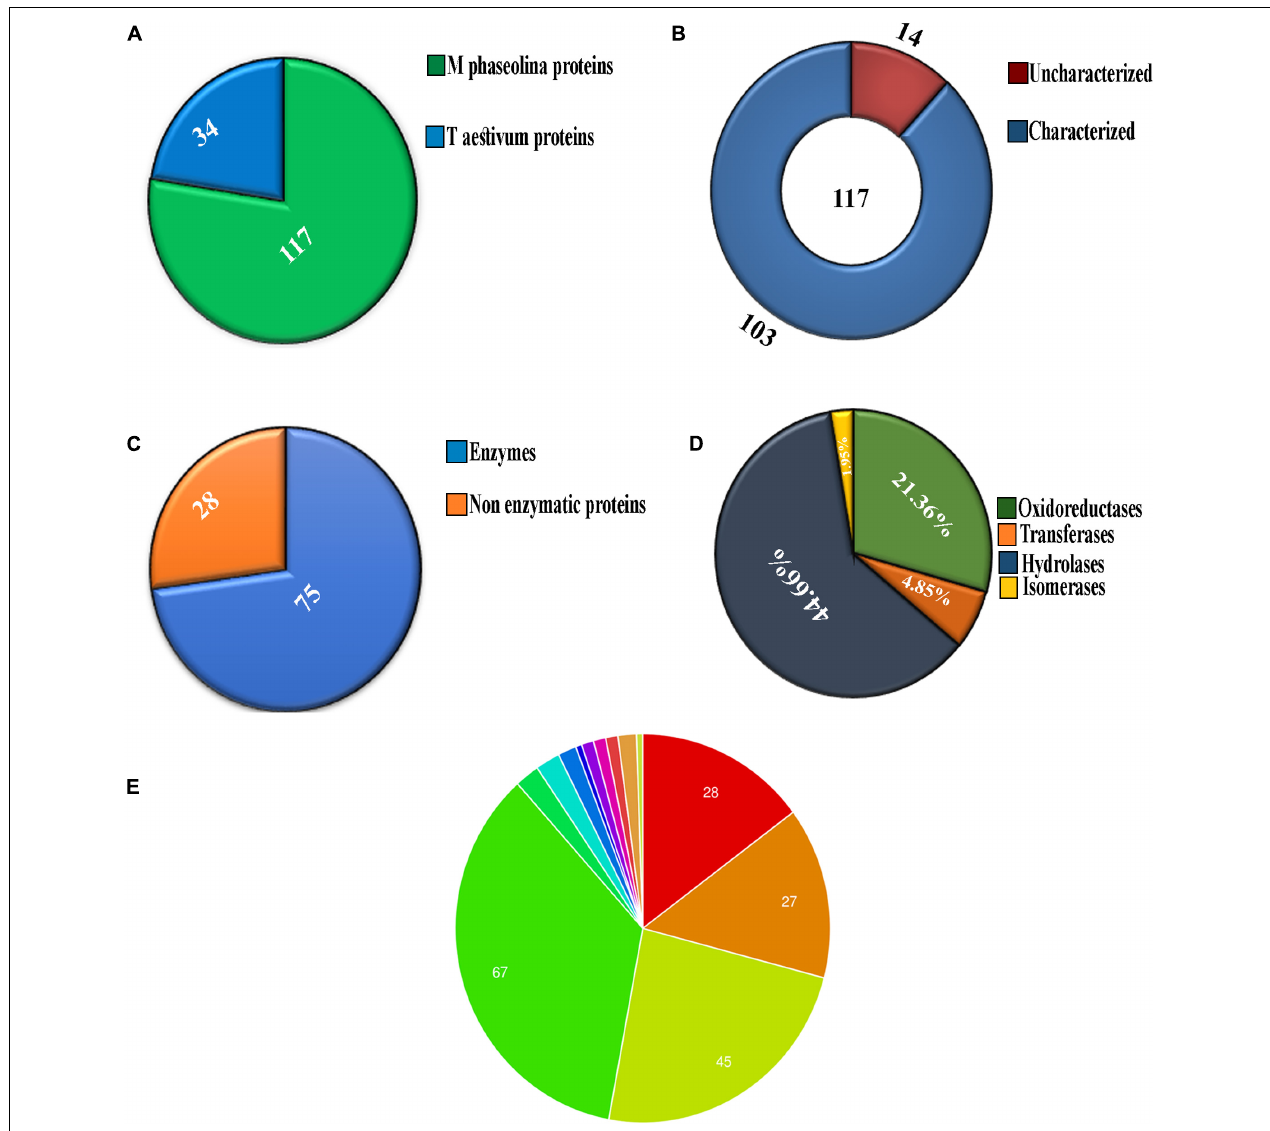
FIGURE 2 | Analysis of secretome obtained from solid-state culture of M. phaseolina grown on wheat bran using LC-ESI-MS/MS. Total 151 proteins were found in LC-ESI-MS/MS analysis. (A) Pie chart represents the number of M. phaseolina and T. aestivum proteins found in LC-ESI-MS/MS. Among 151 proteins, 117 proteins were obtained from M. phaseolina and 34 proteins from T. aestivum . (B) Secretome of M. phaseolina identified by LC-ESI-MS/MS. Among 117 proteins present in the secretome, 14 proteins were found to be uncharacterized and 103 proteins were found to be characterized. (C) Enzymatic and non-enzymatic proteins of M. phaseolina identified by LC-ESI-MS/MS. Among 103 characterized proteins, 28 proteins were nonenzymatic, and the rest 75 proteins were enzymes. (D) Classification of enzymes found in the secretome of M. phaseolina . LC-ESI-MS/MS analysis of the secretome of M. phaseolina identified the following four classes of enzymes: (1) isomerases, (2) hydrolases, (3) transferases, and (4) oxidoreductases. Hydrolases were predominantly present in the aforementioned classification. (E) Molecular function ontology. GO enrichment analysis was performed to get the molecular functions of genes corresponding to the proteins found in the LC-ESI-MS/MS data of M. phaseolina . Most of the genes were found to be involved in different hydrolase activities. Almost 35.5% (67) of the genes corresponding to the proteins are involved in catalytic activity. The involvement of other genes in cellular processes is shown using different color code in the pie chart. All the molecular functions found are as follows: hydrolase activity, hydrolyzing O -glycosyl compounds, hydrolase activity, acting on glycosyl bonds, hydrolase activity, catalytic activity, endo-1,4- β -xylanase activity, serine-type peptidase activity, carboxypeptidase activity, purine ribonucleoside binding, glucosidase activity, polysaccharide binding, catalase activity, choline dehydrogenase activity, purine ribonucleoside triphosphate